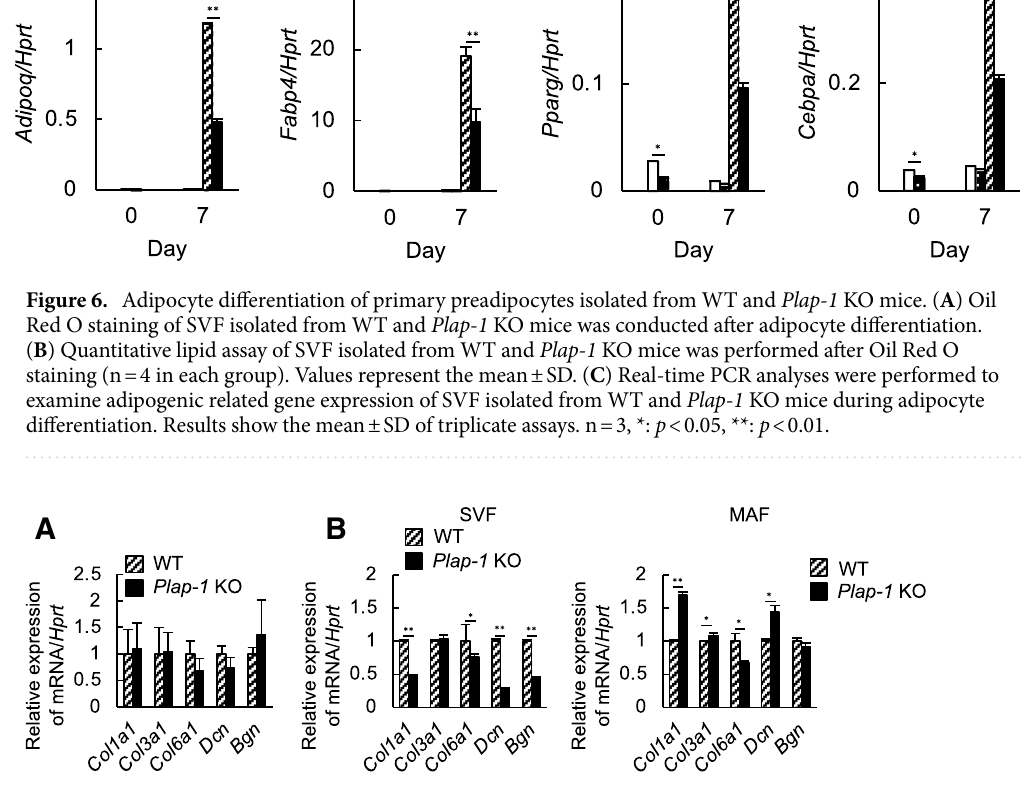
fibrosis of adipose tissue 22 , and the absence of collagen VI results in improved metabolism 23 . We demonstrated that Col6a1 expression was decreased in the SVF of Plap-1 KO mice. The decreased collagen VI expressions may have improved the metabolism of Plap-1 KO mice. Furthermore, Dcn and Bgn expressions were significantly lower in the SVF of Plap-1 KO mice. PLAP-1 may promote fibrosis by affecting the expression of other SLRPs. In adipose tissue fibrosis, adipocytes surrounded by ECM undergo necrosis, and M1 macrophages infiltrate the adipose tissue and cause inflammation 35 . Macrophages produce inflammatory cytokines, such as TNF-α,